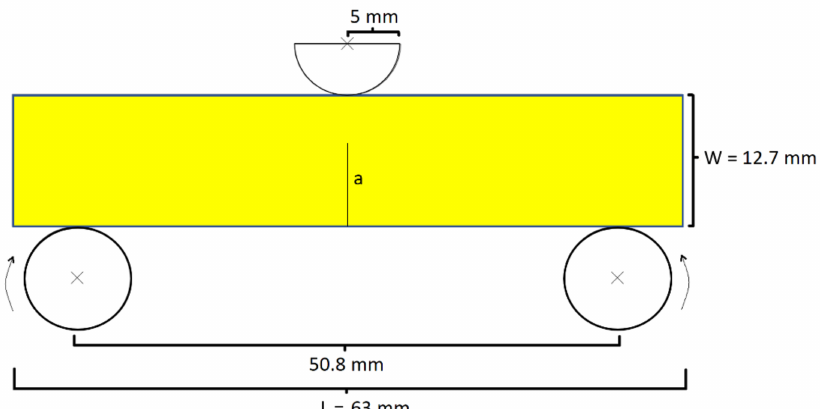
Figure 1. Configuration of the simulated SENB test apparatus within which the stationary bottom pins are